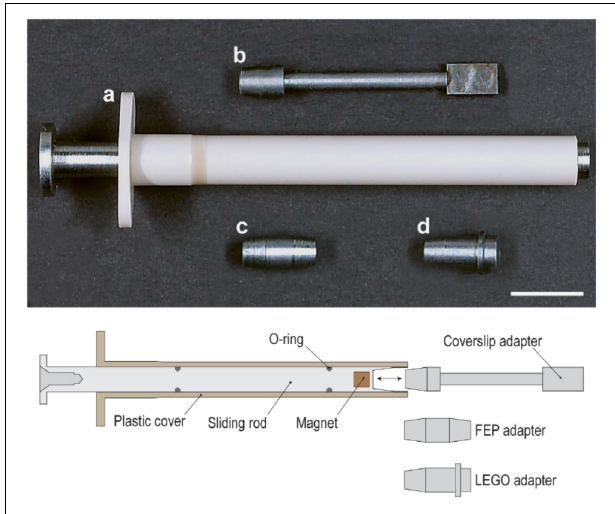
FIGURE 2 | Photograph and schematic diagram of the sliding rod holder and its individual adapters: (a) plastic casing plus sliding steel rod, (b) coverslip adapter, (c) FEP adapter, (d) LEGO adapter. Scale bar: 1 cm.